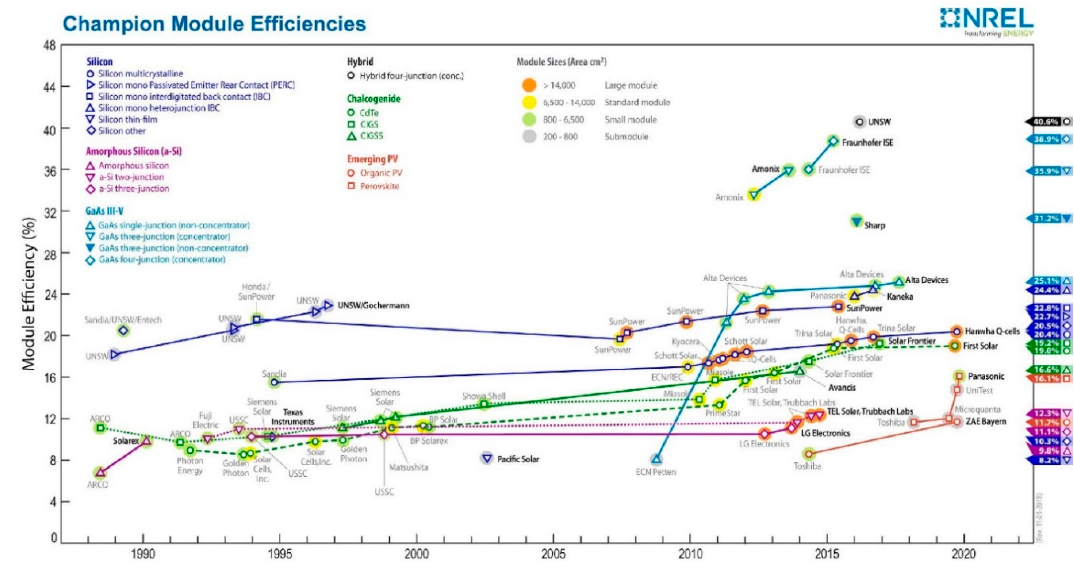
Figure 4. PV module efficiency chart [16].